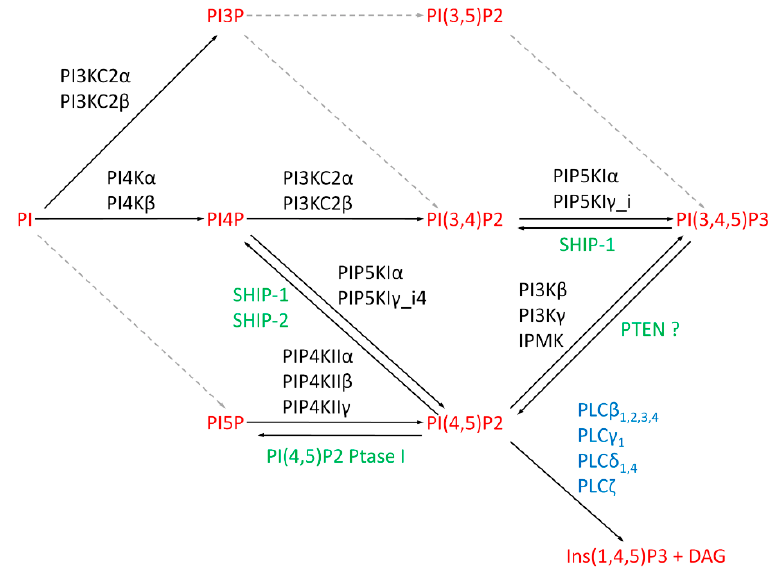
Figure 1. Known pathways of nuclear phosphatidylinositol and phosphoinositides. Depicted known phosphatidylinositol kinases in black and phosphatases in green, as well as their substrates (red). Black arrows indicate phosphorylation or dephosphorylation catalyzed by the known nuclear enzymes. Gray arrows show other potential pathways which might occur in the nucleus, but responsible nuclear enzymes are not yet confirmed. The scheme summarizes published data described in the text.